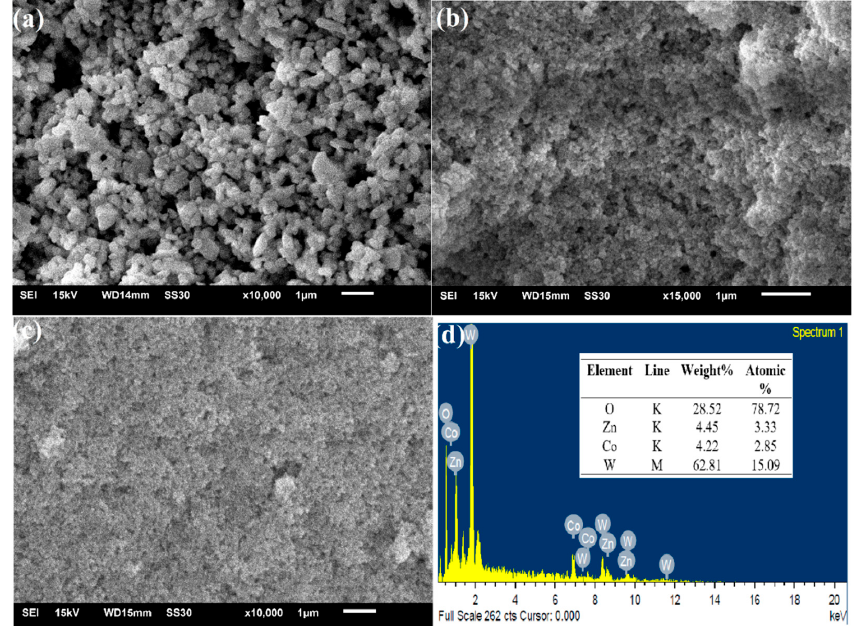
Figure 3. SEM micrographs of ( a ) ZnWO 4 NPs; ( b ) CoWO 4 NPs; ( c ) Zn 0.5 Co 0.5 WO 4 at 1 μ m scale; ( d ) EDX spectra of Zn 0.5 Co 0.5 WO 4 in 0–20 keV range. Furthermore, to figure out the size of the ZnWO 4 , CoWO 4, and Zn 0.5 Co 0.5 WO 4 , TEM analysis was performed (Figure 4a–c). ZnWO 4 (Figure 4a) is composed of particles with a rod-like shape; CoWO 4 (Figure 4b) presented a morphologically spherical shaped particle.